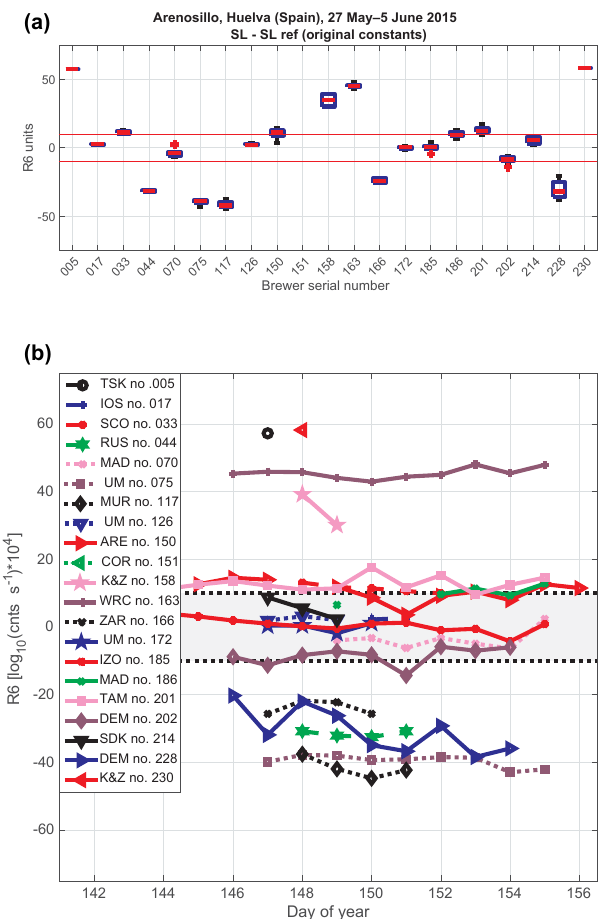
Figure 11. Standard lamp R6 difference with respect to the R6 ref- erence value from the last calibration during the blind days, before the maintenance. The upper panel shows the mean value for each in- strument and the lower panel the daily mean during the campaign. Variations within the ± 10 units range ( ∼ 1% in ozone) from the ref- erence value are considered normal, whereas larger changes would require further analysis of the instrument performance.